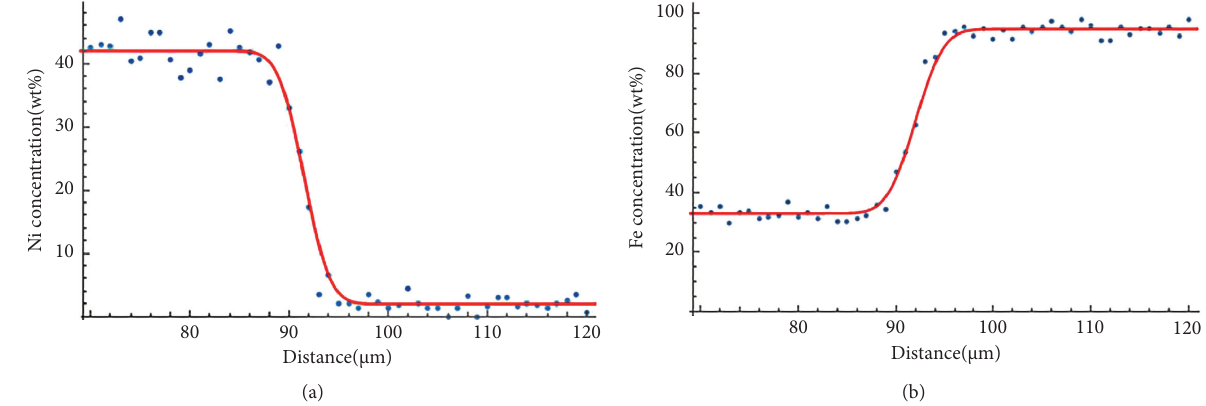
Figure 3: The content of Ni and Fe distribution at the interface and its fitting curve: (a) Ni and (b) Fe.